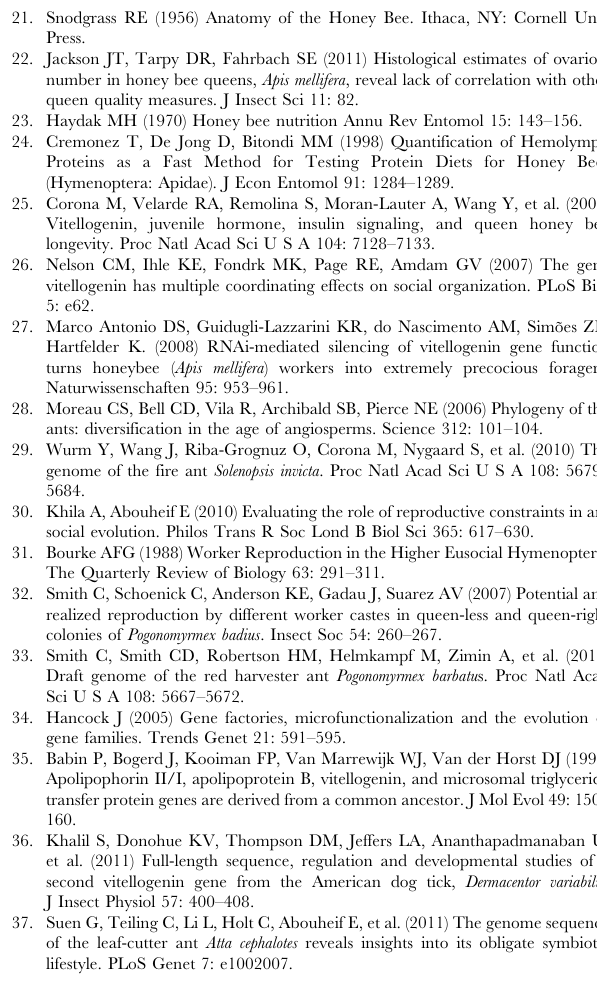
Table S1 Paralog-specific primers used for qRT-PCR (5 9 -3 9